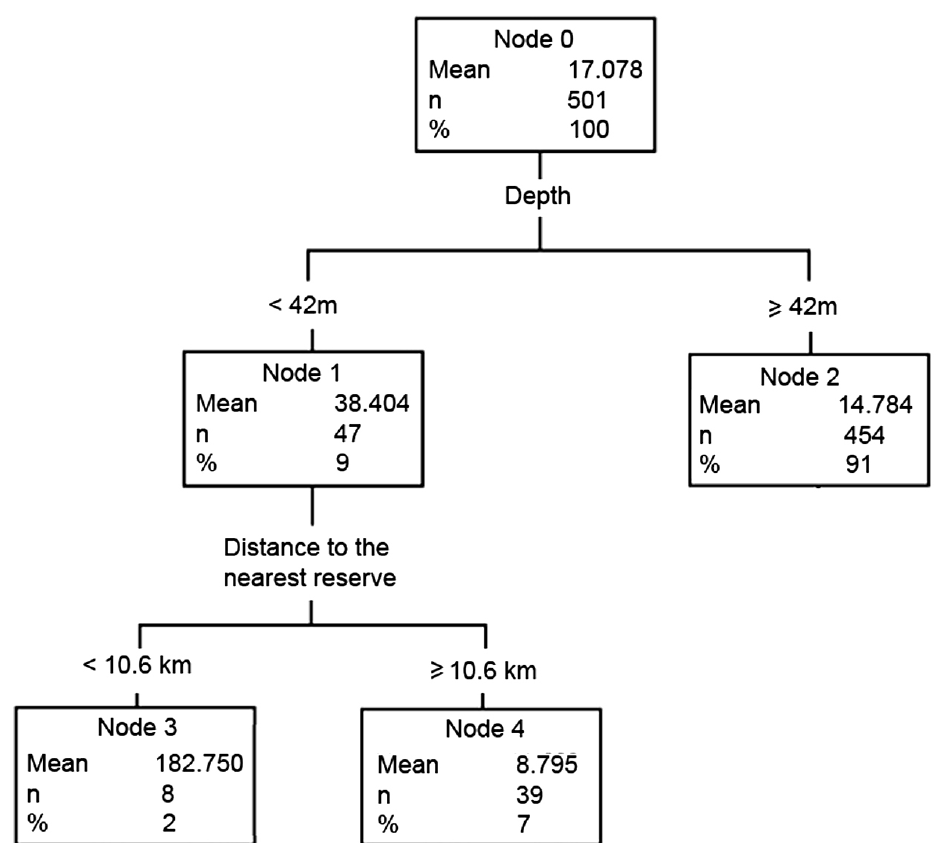
Fig. 1. – First tree selected by the evtree algorithm when all the variables are included in the